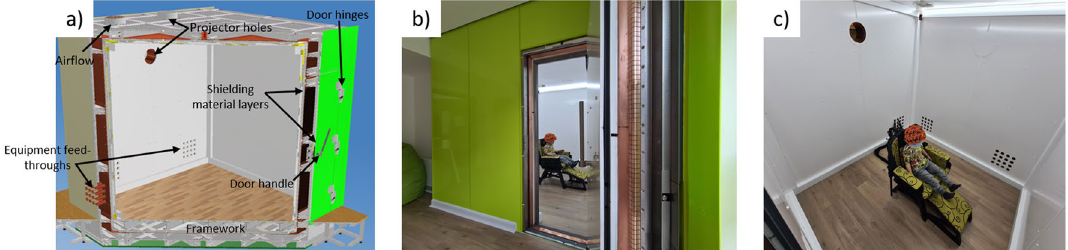
Figure 1. The Light MuRoom magnetically shielded room. ( a ) Computer model of the Light MuRoom, cross- section revealing framework and layer structure. ( b ) Photograph of the exterior of the participant facing side of the MSR. ( c ) Photograph of the interior of the MSR with wearable OPM-MEG system mounted on a plastic